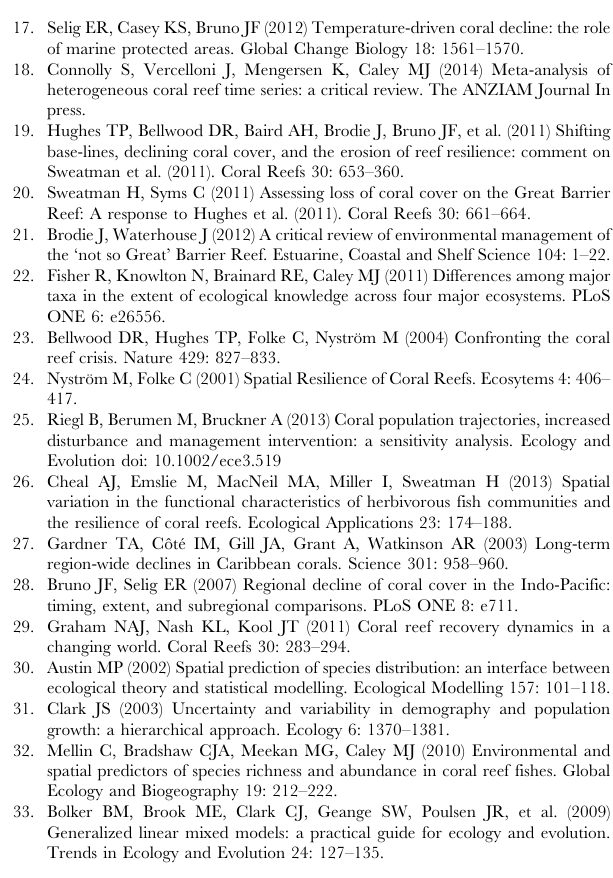
Figure S1 Illustration of the poor estimation of slope ( c 1h ) and intercept ( c 0h ) parameters based on three MCMC chains from a simulation of 200,000 iterations, a burn-in of 100,000 iterations and a thinning rate of 50 iterations. Differences in estimated values in MCMC chains demonstrate the non-convergence of the algorithm to a unique posterior distribution for each parameter. This non-convergence also affects the variance of the parameters with ranges of the 95% credible intervals (RCIs) varying between 0.1 and 1. (TIFF) Code S1 R and WinBUGS code to implement the Bayesian semi-parametric hierarchical model.